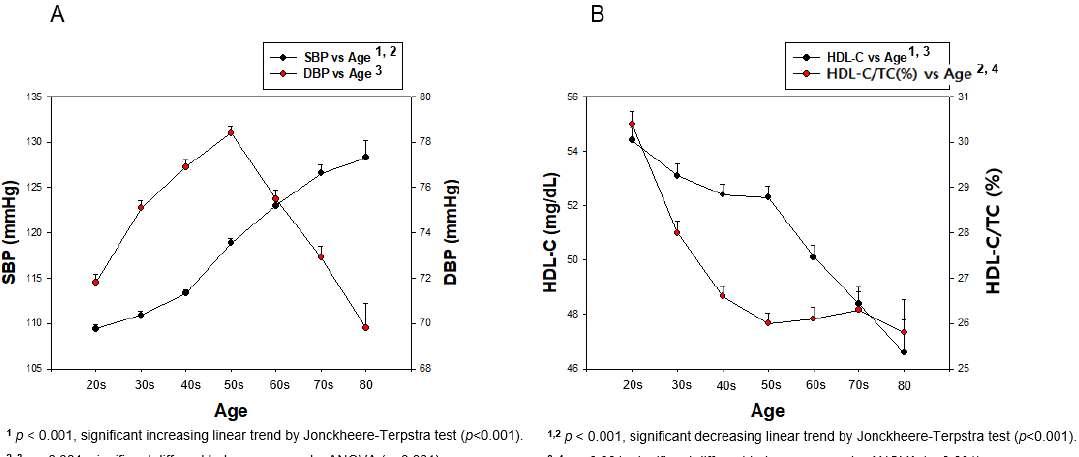
Figure 8. Change in BP and HDL-C depends on age in total population during entire life. Direct